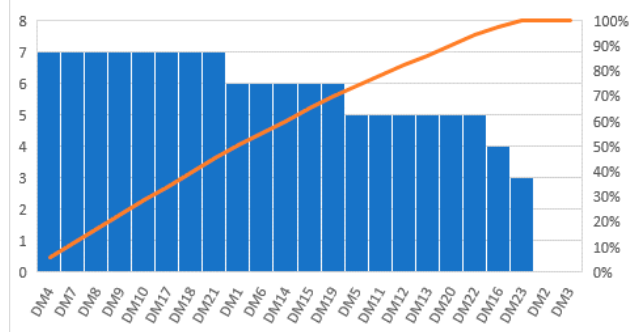
Figure 4. Comparing the results extracted from Table 3 (cumulated data).